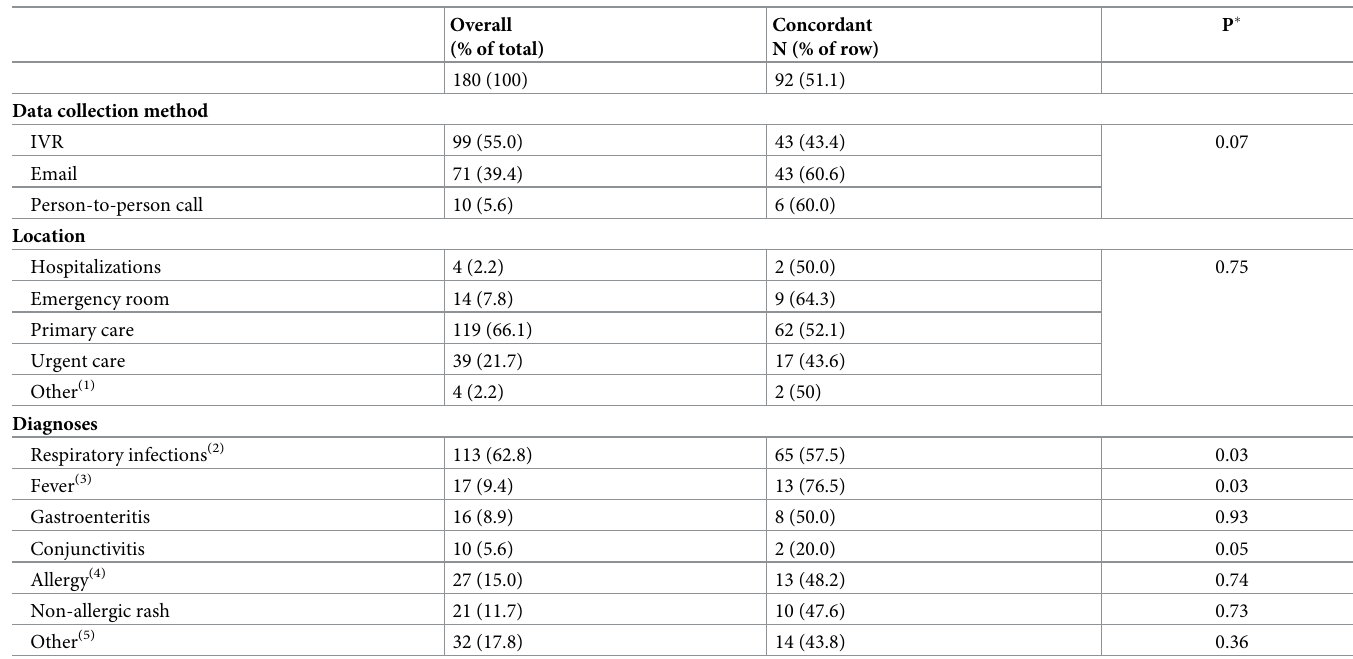
Table 1. Concordance/discordance by diagnosis and